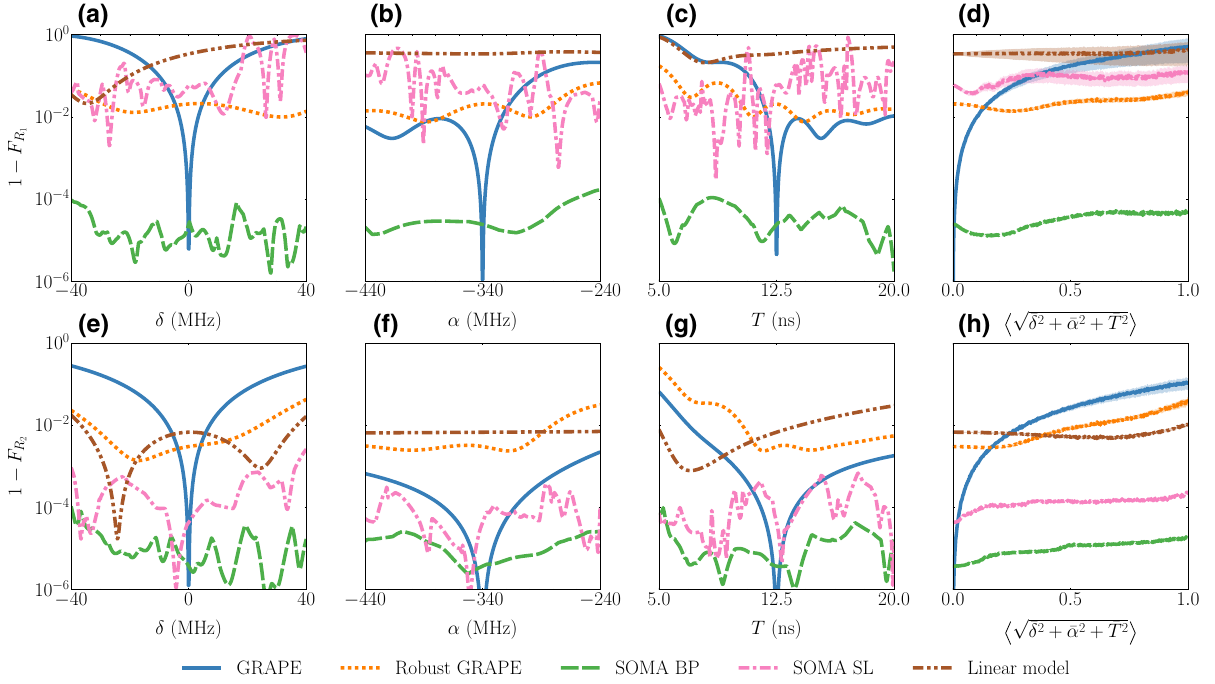
FIG. 4. The infidelity of pulses predicted by the different optimization methods for the R 1 (θ = π/ 2 ) gate (first row) and the R 2 (θ = π/ 2 ) gate (second row) as a function of three different quantum control problem parameters: (a),(e) the detuning δ between the qubit frequency and the driving frequency; (b),(f) the nonlinearity α of the qutrit; and (c),(g) the total gate duration T . (d),(h) The average performance (1000 test samples) of the algorithms as a function of the radial distance from the center (cid:4) λ 0 of the parameter space. The terms ¯ δ , ¯ α , ¯ T indicate that the problem parameters are renormalized to the space [0, 1] D —see Appendix B. The shaded regions around each plot line show the standard deviation of the corresponding infidelities. A more detailed discussion about the standard deviation can be found in Appendix B. Both gates are optimized with four Fourier components for each one of the two control fields—see